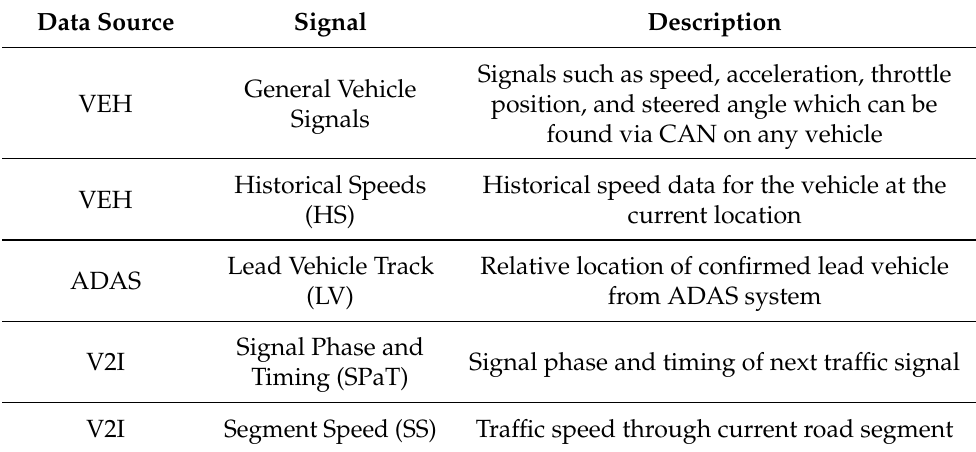
Table 1. Data sources and associated signals.